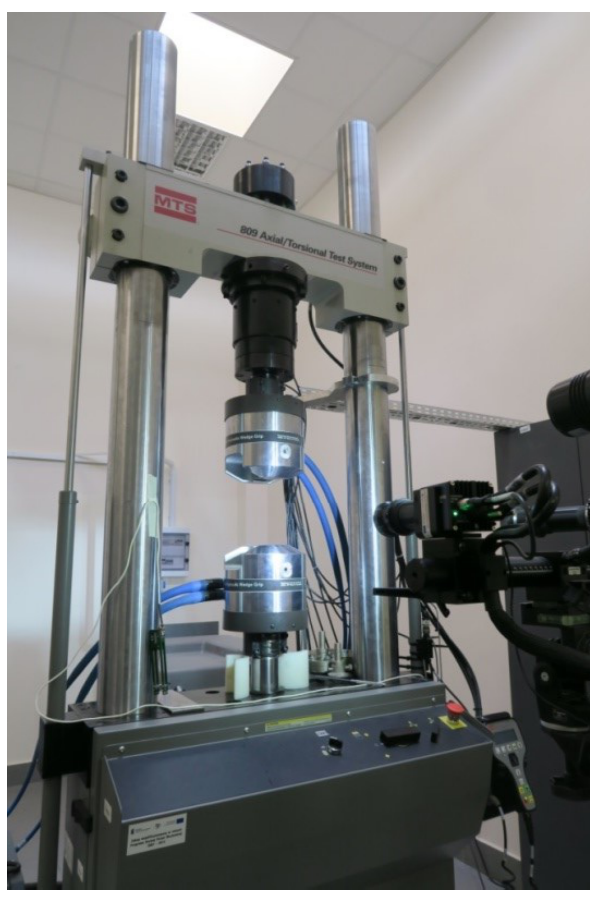
Figure 4: MTS 809.10 strength machine